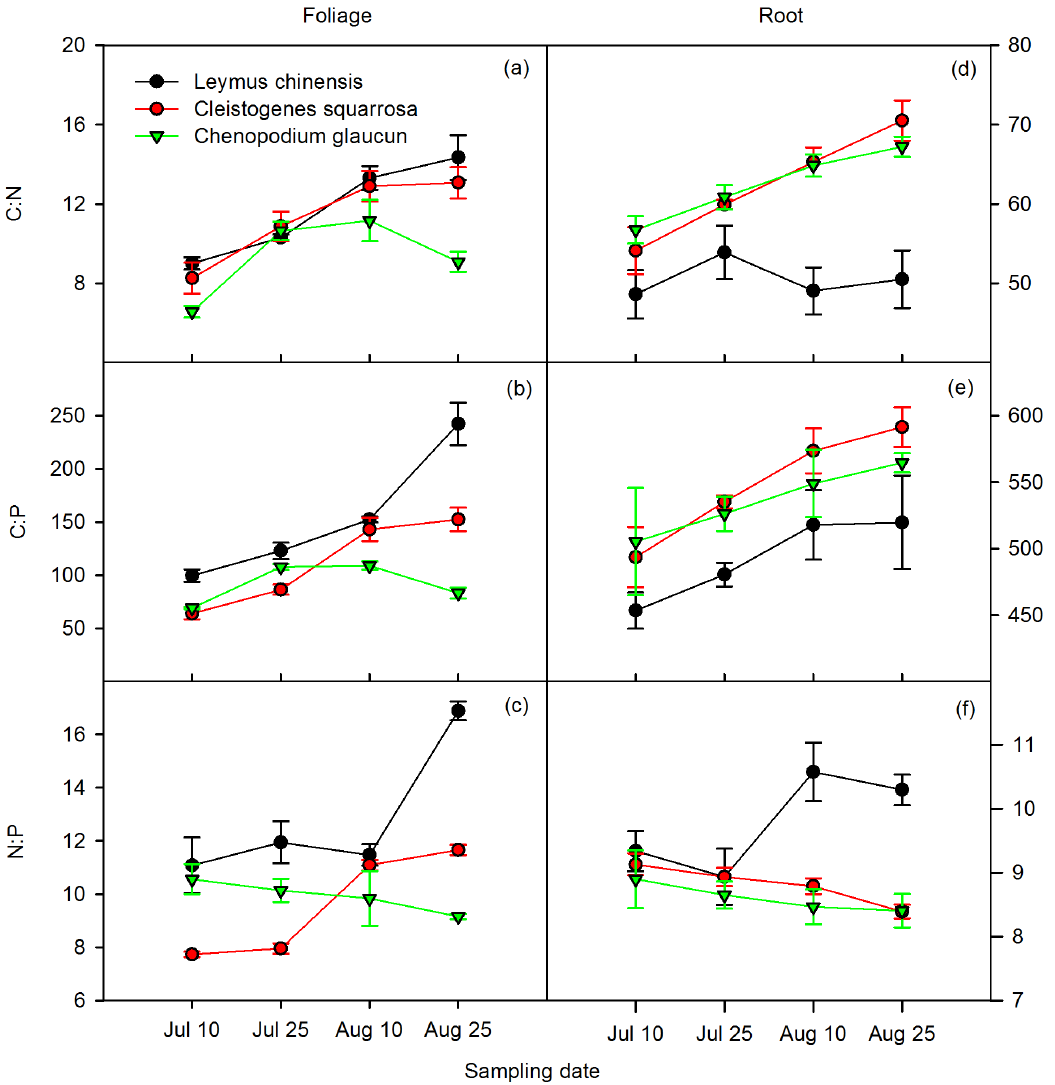
Figure 1. Change in C:N, C:P, N:P ratios for leaf (left) and root (right) tissue over time for three grassland species in the sand culture study. Error bars are SEM.